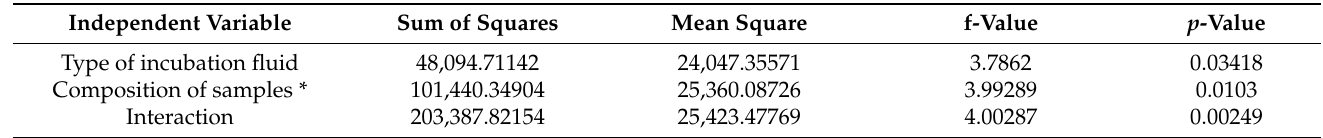
Table 4. Statistical analysis of obtained data based on the two-way analysis of variance (ANOVA) with